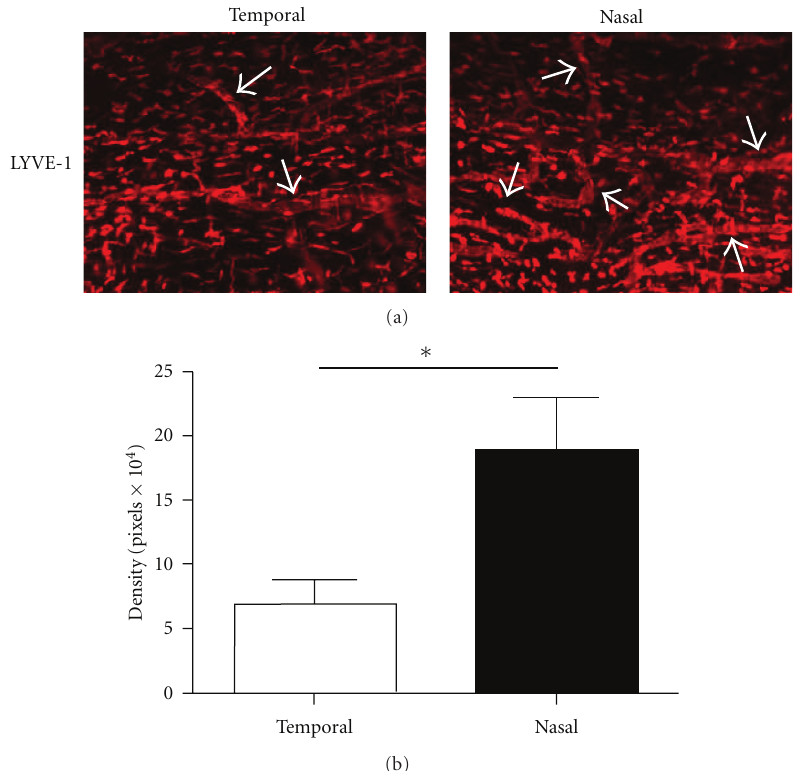
Figure 2: Comparison of lymphatic distribution in the nasal versus temporal side of normal conjunctiva. (a) Representative immunofluorescent micrographs demonstrating that lymphatic vessels were more prominent in the nasal side. LYVE-1: red; Original Magnification: × 50. (b) Summary of repetitive experiments. ∗ P < 0 .